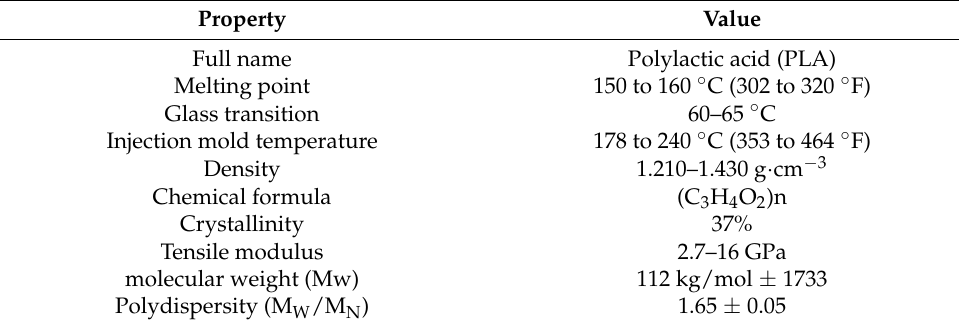
Table 4. Material properties of the data sheet.